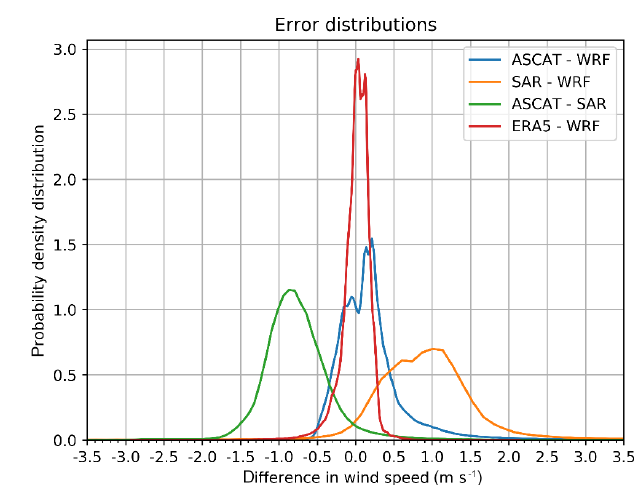
Figure 6. Error distribution of the wind speed difference at 100ma.m.s.l. for ASCAT minus WRF, SAR minus WRF, ASCAT minus SAR and ERA5-WRF. The distributions are normalized so the area below the curves sums to